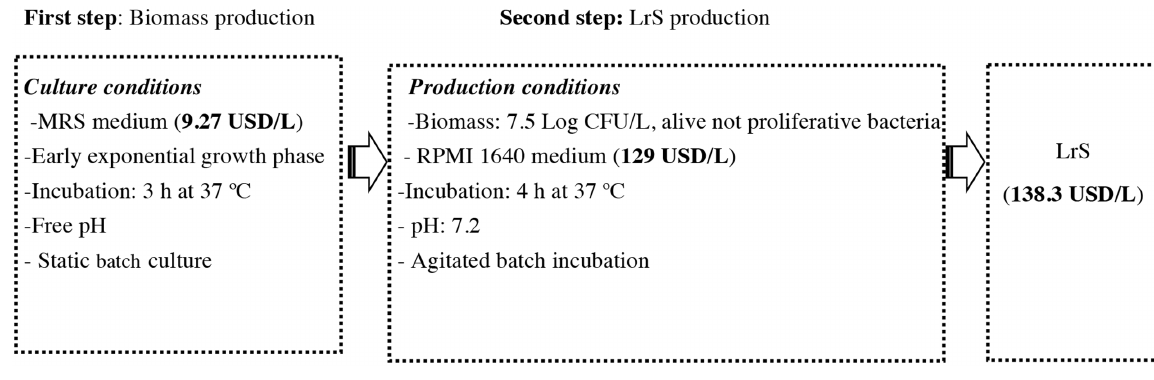
Fig 1. Process for obtaining of anti-inflammatory-soluble factor (LrS) from L . reuteri CRL1098 at laboratory scale.